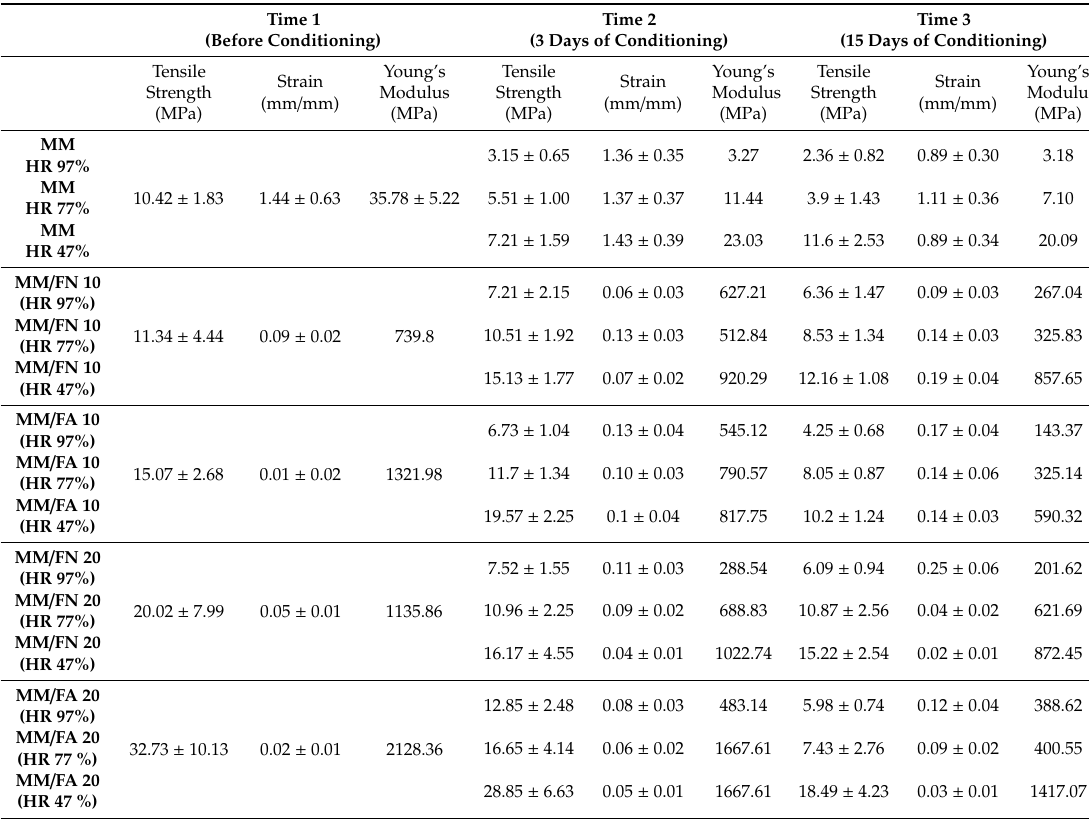
Table 3. Tension mechanical properties of Mopa-Mopa resin and biobased composites with native and alkalized fique fibers at 10 and 20%